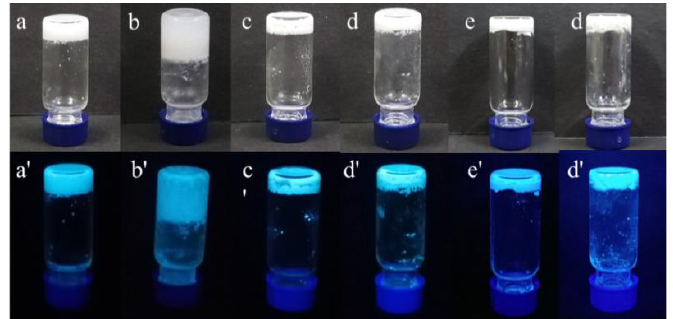
Figure 1. Images of gels of 1 in different solvents: ( a , a ’ ) DMF/H 2 O (4/1, v / v ); ( b , b ’ ) DMSO/H 2 O (4/1, v / v ); ( c , c ’ ) methanol; ( d , d ’ ) ethanol; ( e , e ’ ) ethyl acetate; ( f , f ’ ) acetonitrile (gel concentration is its corresponding CGC).